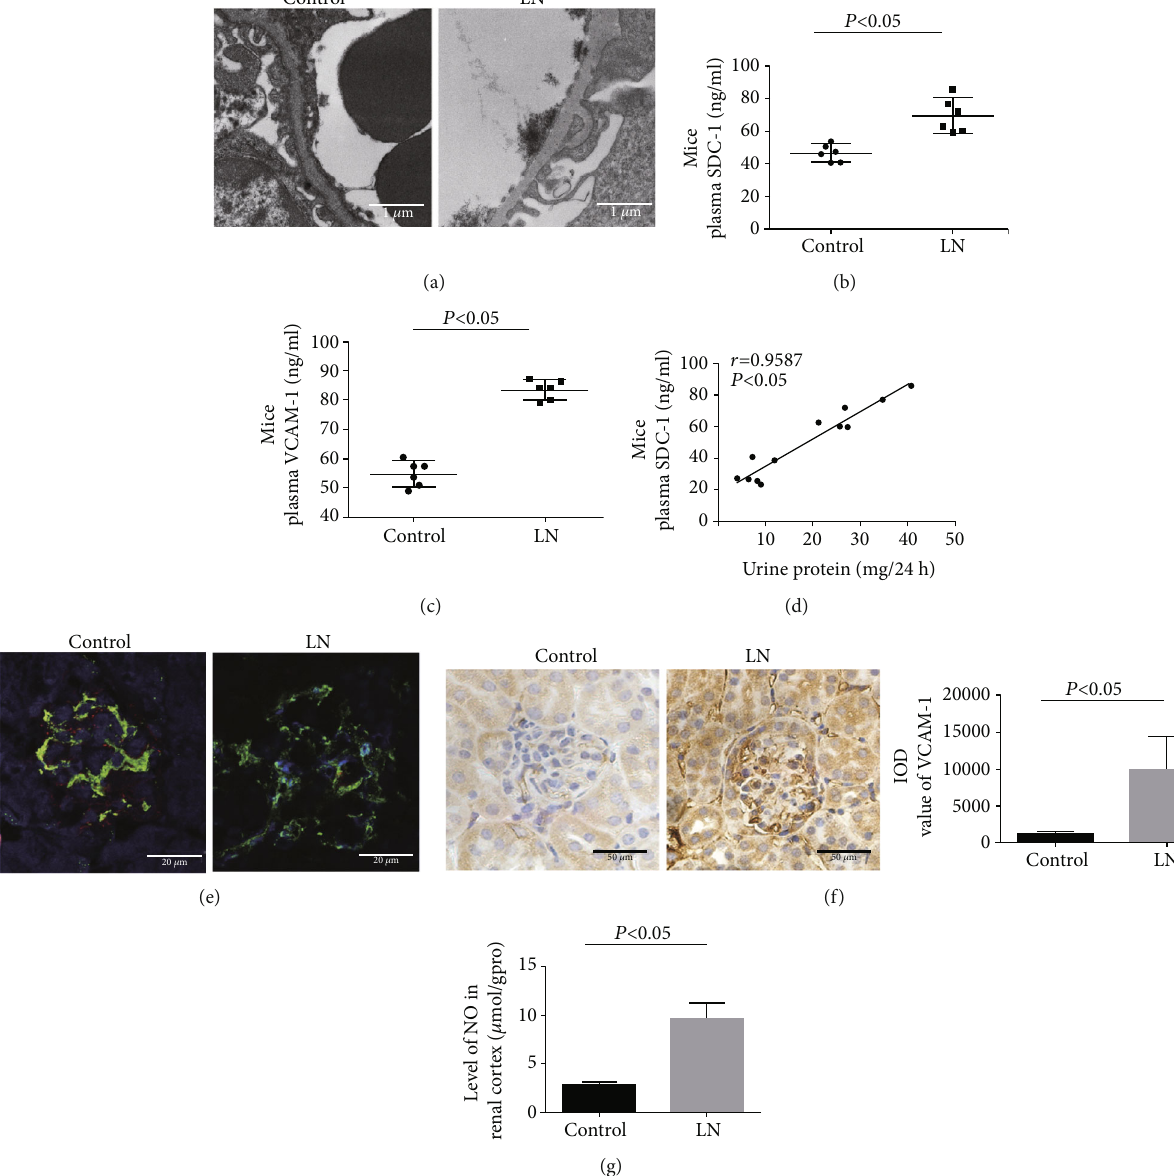
Figure 2: Glomerular endothelial glycocalyx shedding was associated with proteinuria in MRL/lpr mice. (a) Glomerular endothelial glycocalyx of mice was observed by TEM. (b, c) The level of SDC-1 and VCAM-1 in plasma of control and LN mice was measured by ELISA ( n = 6 ). (d) Correlation analysis of plasma SDC-1 level and 24h proteinuria in mice ( r = 0 : 9587 , p < 0 : 05 ). (e) IF of SDC-1 (red) and CD31 (green) in glomeruli of control and LN mice. (f) IHC of VCAM-1 in mouse glomeruli of control and LN groups. (g) The level of NO in the renal cortex of control and LN mice was detected ( n = 6 ). NO: nitric